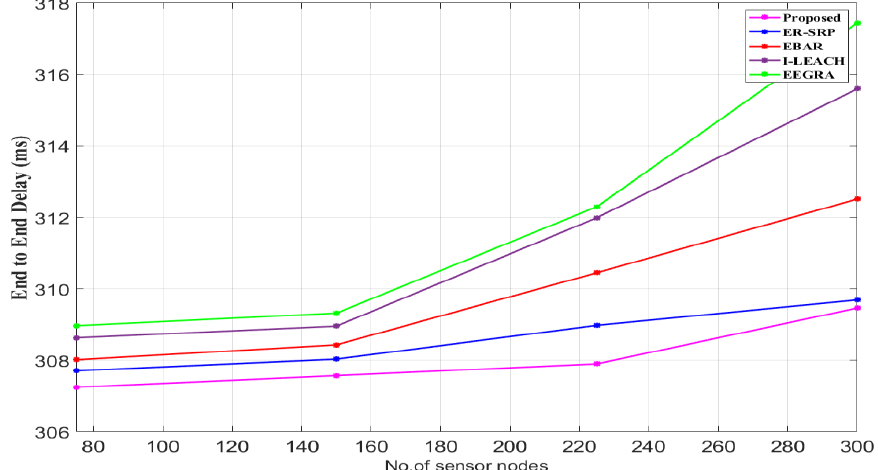
Figure 10. Comparison of end–end delay.